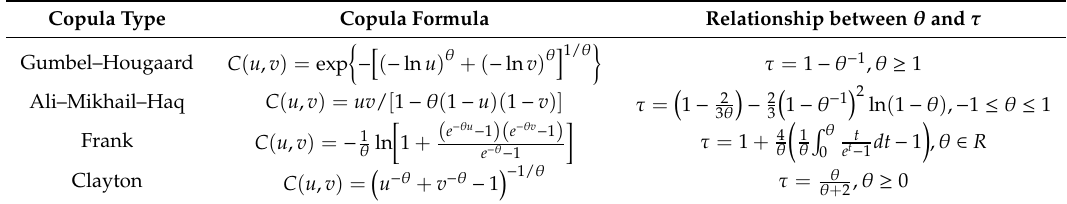
Table 3. Archimedean copula functions and the parameters